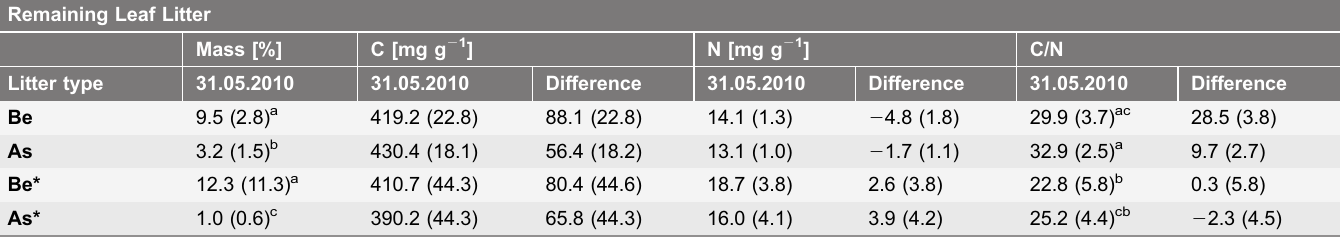
Values were calculated for all pure treatments of unlabeled and labeled (*) leaf litter of beech (Be) and ash (As). Represented are mean values with their standard deviation in parenthesis. High-letters represent significant differences (Kruskal-Wallis test followed by Mann-Whitney U test, p , 0.05) between the different litter types.